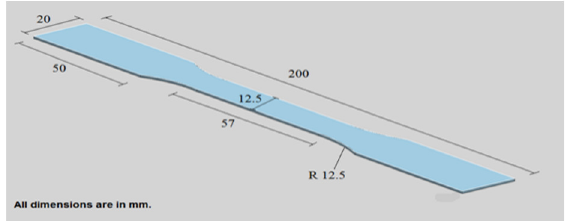
Fig. 1. Dimensions of the tensile test specimen according to ASTM standard and E8M